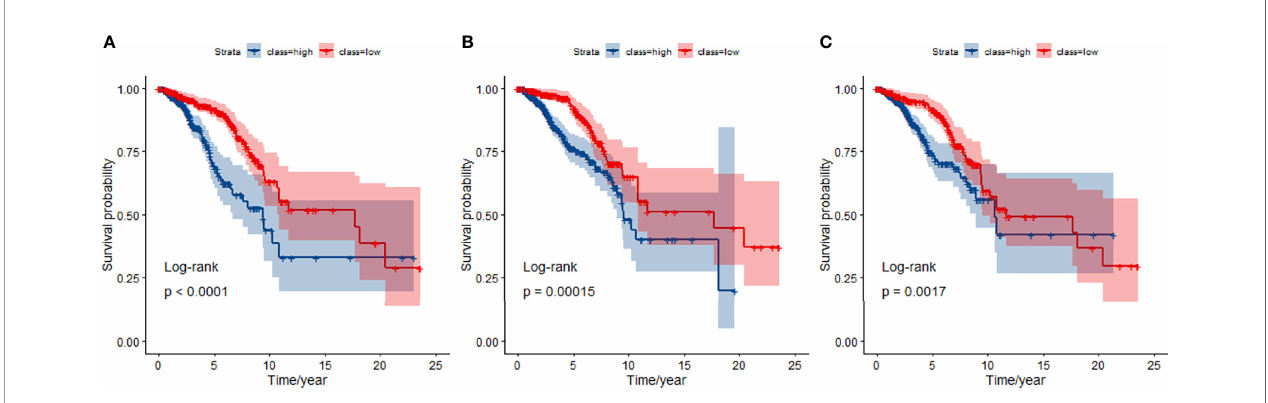
FIGURE 4 | Kaplan-Meier curves for overall survival at 5-year classi fi ers of mRNA expression data in TCGA. (A) Kaplan-Meier curves for JDINAC classi fi er, (B) Kaplan-Meier curves for logistic regression classi fi er, and (C) Kaplan-Meier curves for random forest classi